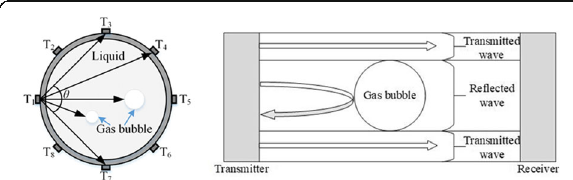
Fig. 1 A physical model and working principle of ultrasonic transmission